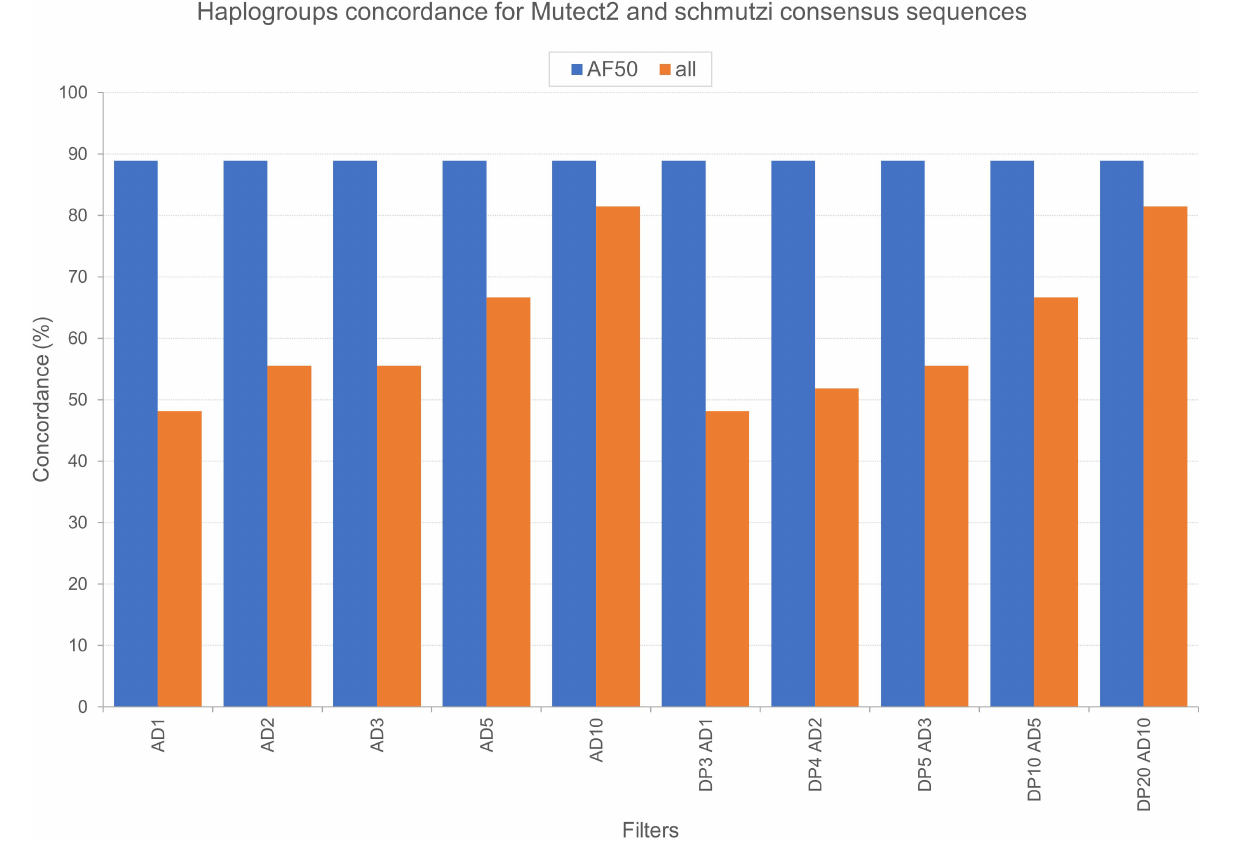
FIGURE 4 | Concordance of haplogroups predicted for Mutect2 and schmutzi consensus sequences of Polizzello samples. The percentage of concordance was calculated on the whole dataset by comparing haplogroups predicted for consensus sequences generated from Mutect2 variants, filtered according to different patterns of filters, to haplogroups assigned to schmutzi consensus sequences. Mutect2 sequences included variant alleles with minimum fraction = 50% (AF50) or alternatively all those detected in non-multiallelic sites (all). AD1, minimum variant allele depth = 1; AD2, minimum variant allele depth = 2; AD3, minimum variant allele depth = 3; AD5, minimum variant allele depth = 5; AD10, minimum variant allele depth = 10; DP3, minimum total depth = 3; DP4, minimum total depth = 4; DP5, minimum total depth = 5; DP10, minimum total depth = 10; DP20, minimum total depth =